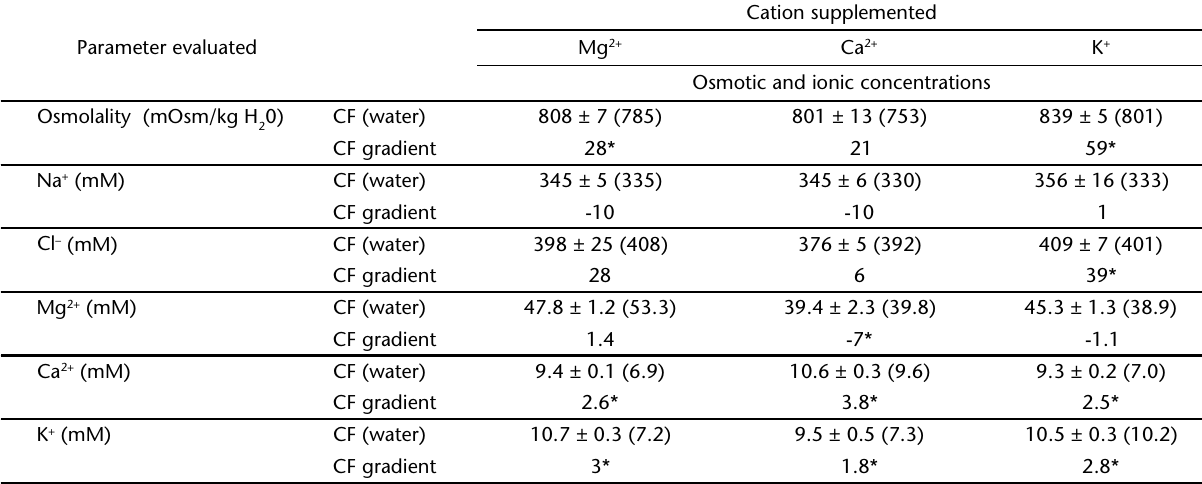
Table I. Perivisceral coelomic fluid (CF) concentrations, mean ± standard error of the mean (n = 6), after six hours of exposure to cation (Mg 2+ , Ca 2+ or K + )-supplemented diluted sea water (25). In parenthesis, average of the respective values for the aquarium water samples (measured in duplicates). Below CF and water values, the difference (= gradient) between CF concentration in supplemented sea water and CF concentration in simply diluted sea water of 25, meaning that the addition of the cation interfered on the CF concentration for that ion, or in its